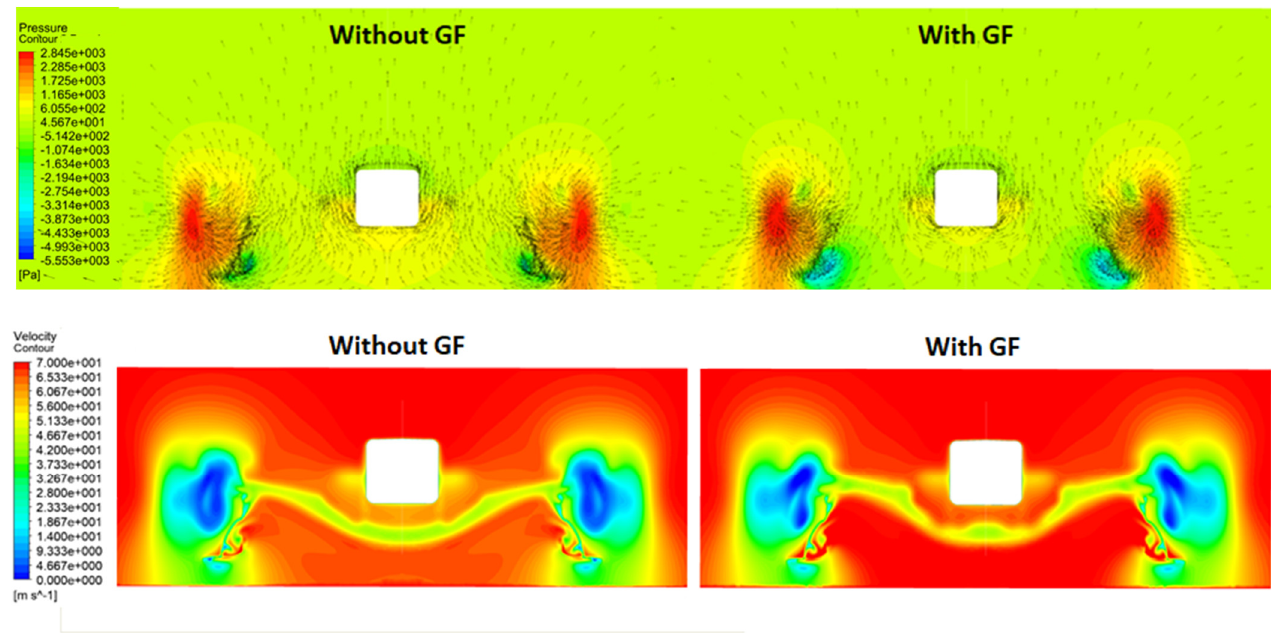
Figure 9. Comparison on the y 2 plane of streamline between the case without ( left ) and with ( right ) GF. The same fluid dynamics analysis was performed on the x 2 plane to understand the increase in drag and in downforce on the endplate. Pressure and velocity contours are reported in Figure 10.